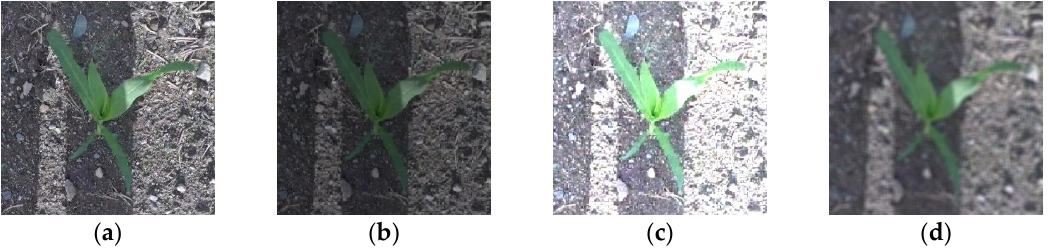
Figure 7. Image augmentations: (a) original image; (b) reduced brightness; (c) increased brightness; (d) blur processing. Table 2. Generated datasets.